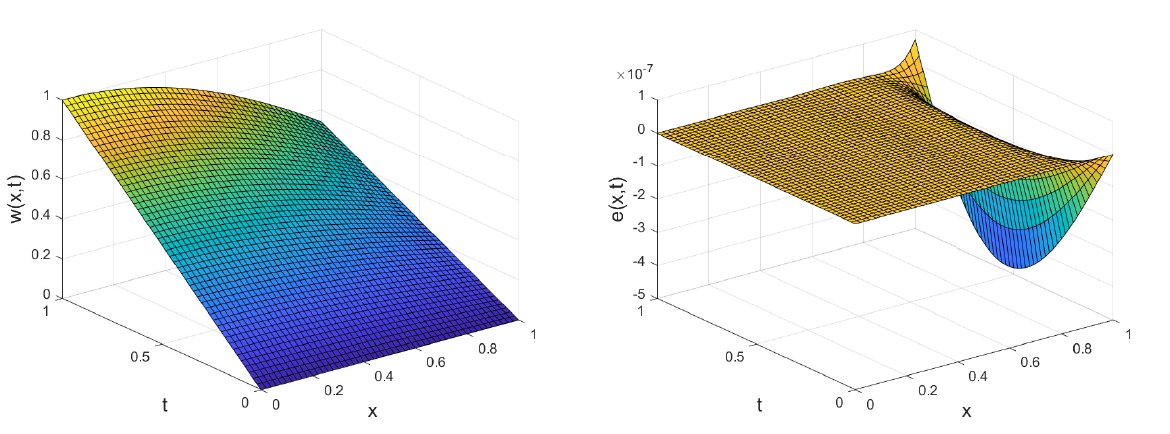
Figure 4. Plot of the approximate solution and absolute value of the error for Example